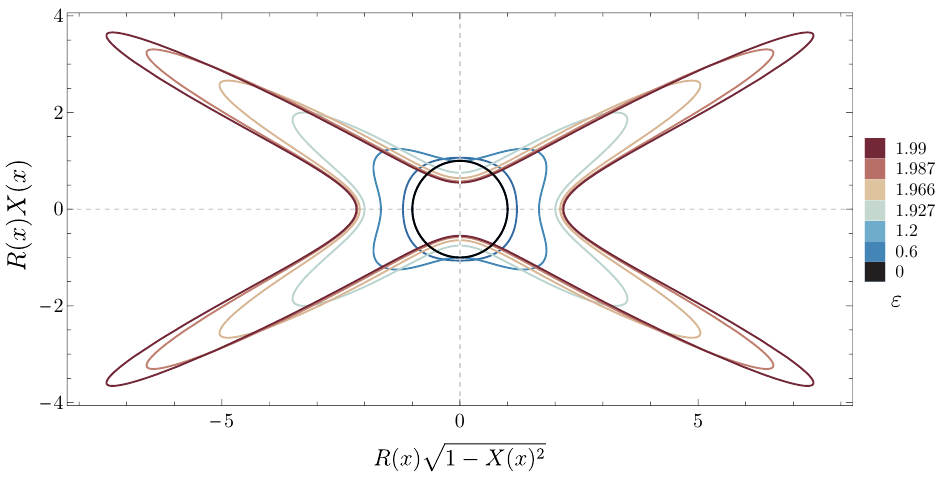
Figure 3 . Hyperbolic embedding of the cross section of the black hole horizons, for several values of the parameter " and a (cid:12)xed temperature T = 1 =(cid:25) . As we increase " , the arms of the horizon cross section get stretched further apart. This picture is qualitatively the same for T (cid:21) 1 =(cid:25) .